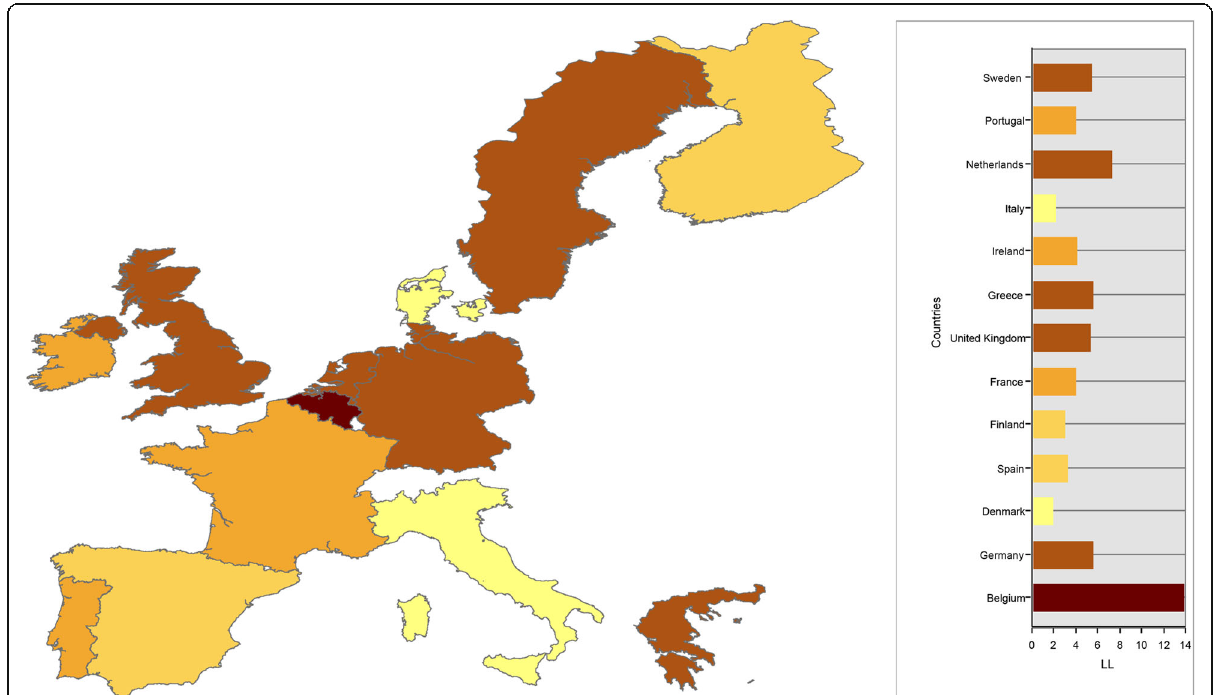
Fig. 13 The weighting of the Load Lines Protocol deficiencies as a result of AHP